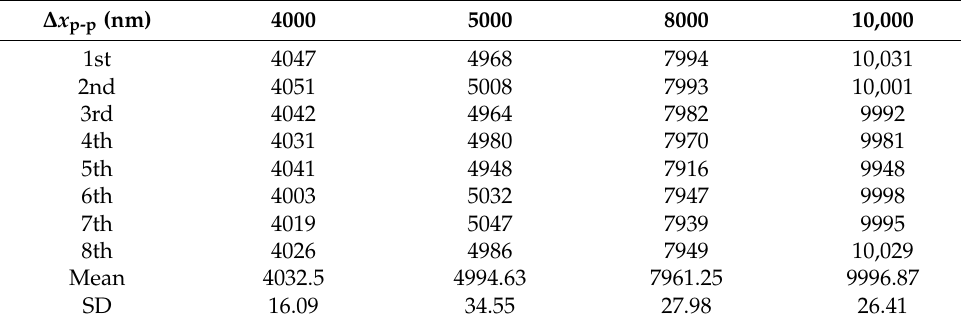
Table 1. Measurement results of in-plane displacement ∆ x .